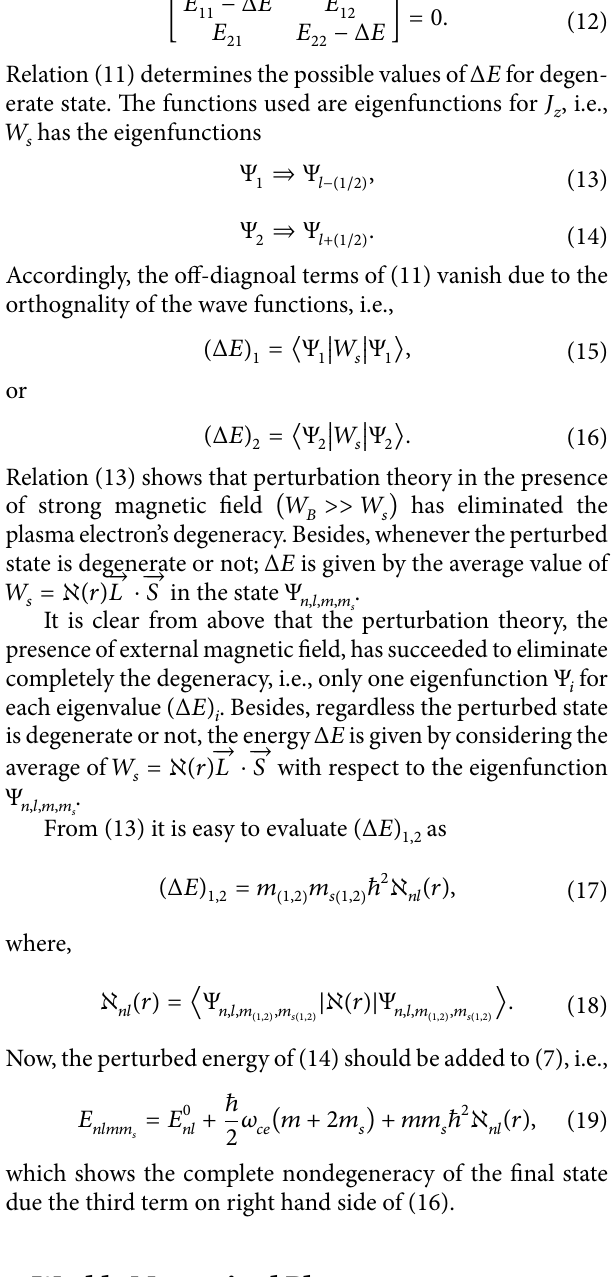
Table 1: Degenerate, and nondegenerate electron states in magnet- ized plasma.